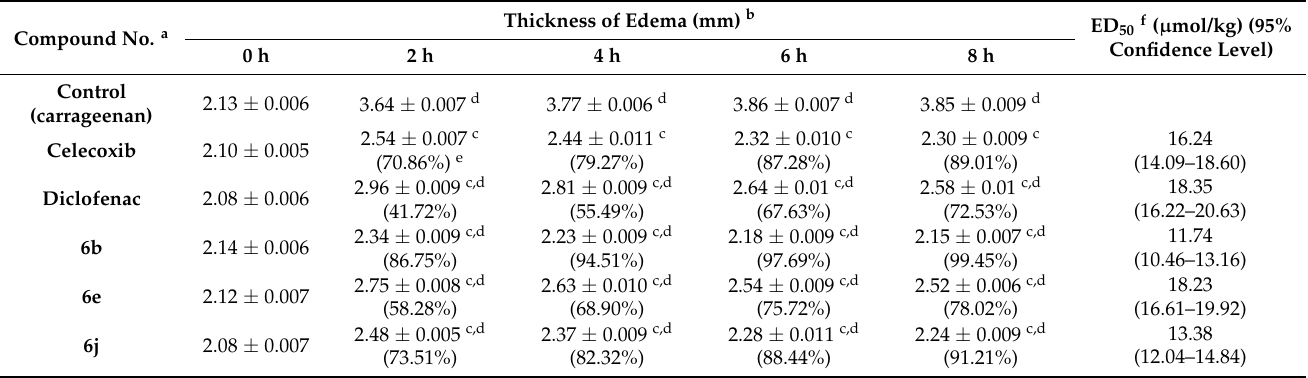
Table 2. Effects of the tested compounds 6b , 6e and 6j on carrageenan-induced paw edema in mice (mm) *; percentage inhibition of paw edema and ED 50 values ( µ mol/kg).